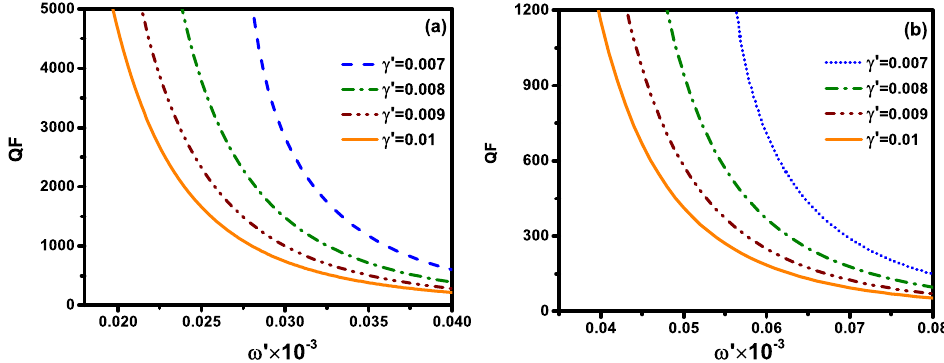
Figure 9. ( a ) SB and ( b ) TB TM SPs QF versus SP energy for several values of γ (cid:48)